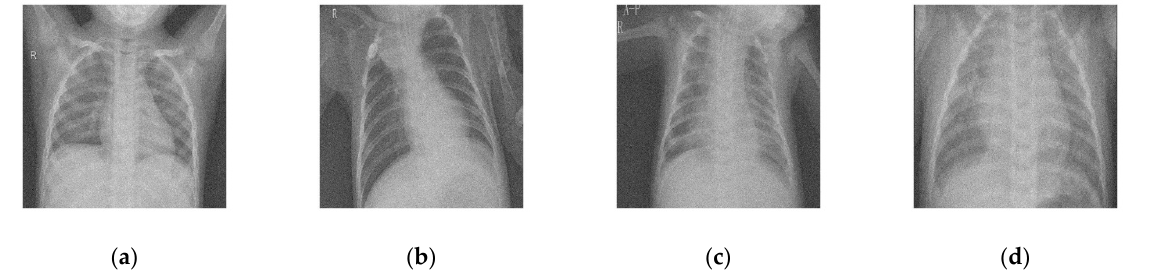
Figure 3. COVID ‐ 19 noisy CT image dataset corresponding to Figure 2; ( a ) Noisy CT1 image; ( b ) Noisy CT2 image; ( c ) Noisy CT3 image; ( d ) Noisy CT4 image.